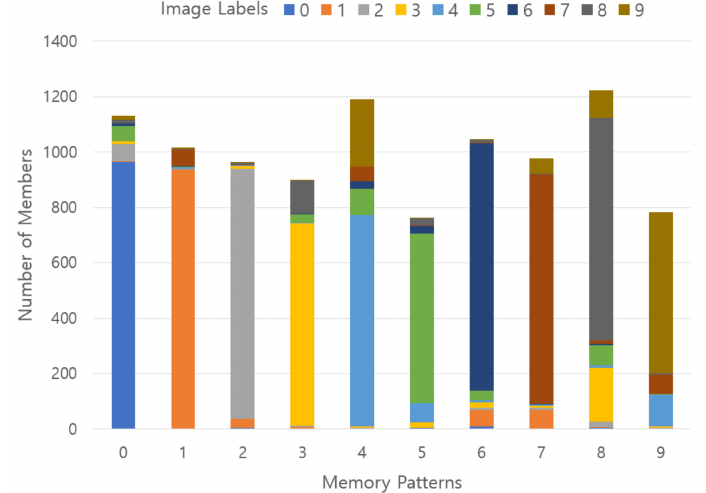
Figure 21. Results of stored memory pattern in an experiment using 20% SDR overlap with the pre-memory process; x -axis represents the memory patterns, y -axis describes the number of members belonging to each memory pattern, and a vertical color code indicates a ground-truth label ratio belonging to each memory pattern.